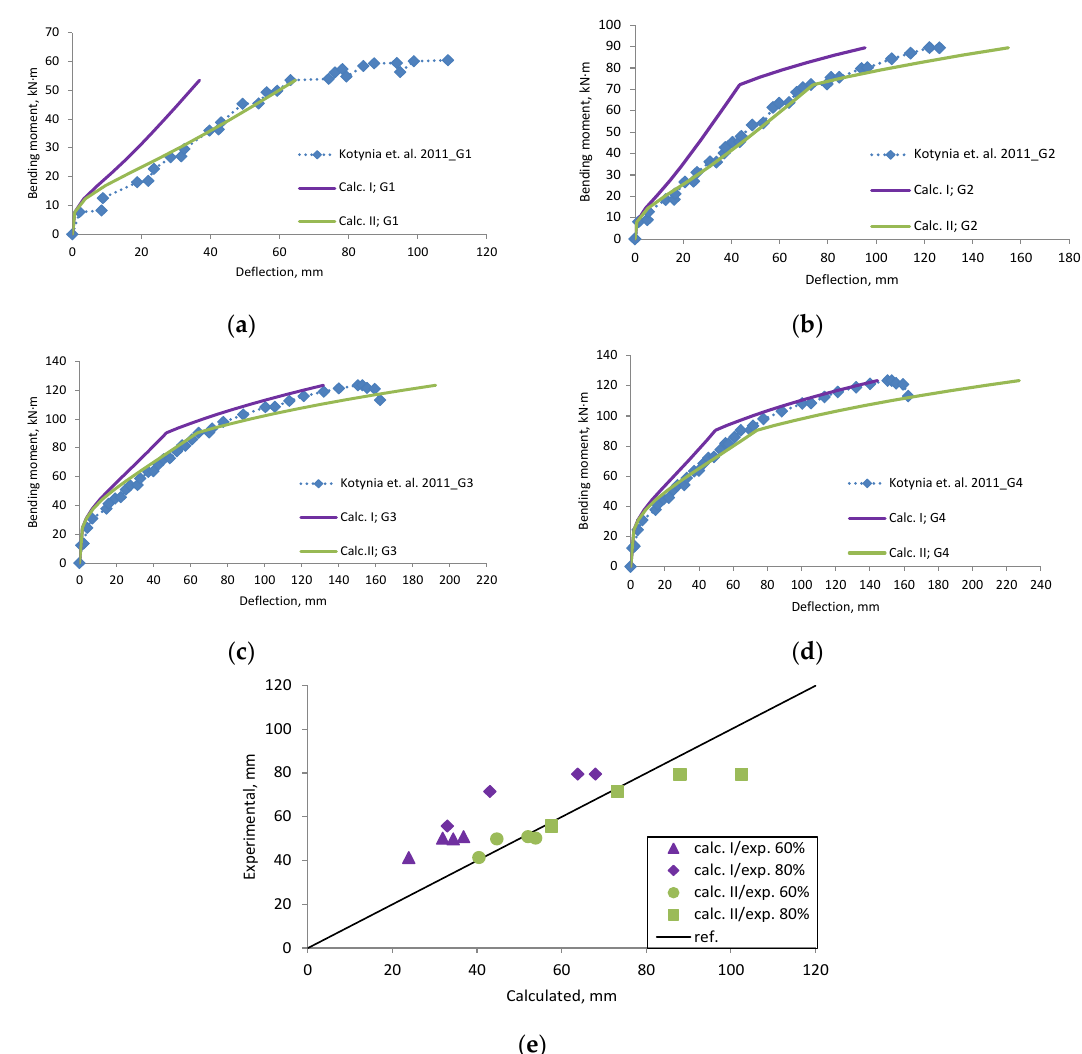
Figure A13. Kotynia et al., 2011 [36] research beams deflection compared with calculated, ( a ) beam G1; ( b ) beam G2; ( c ) beam G3; ( d ) beam G4; ( e ) scatter of the results at 60% and 80% of the ultimate load.